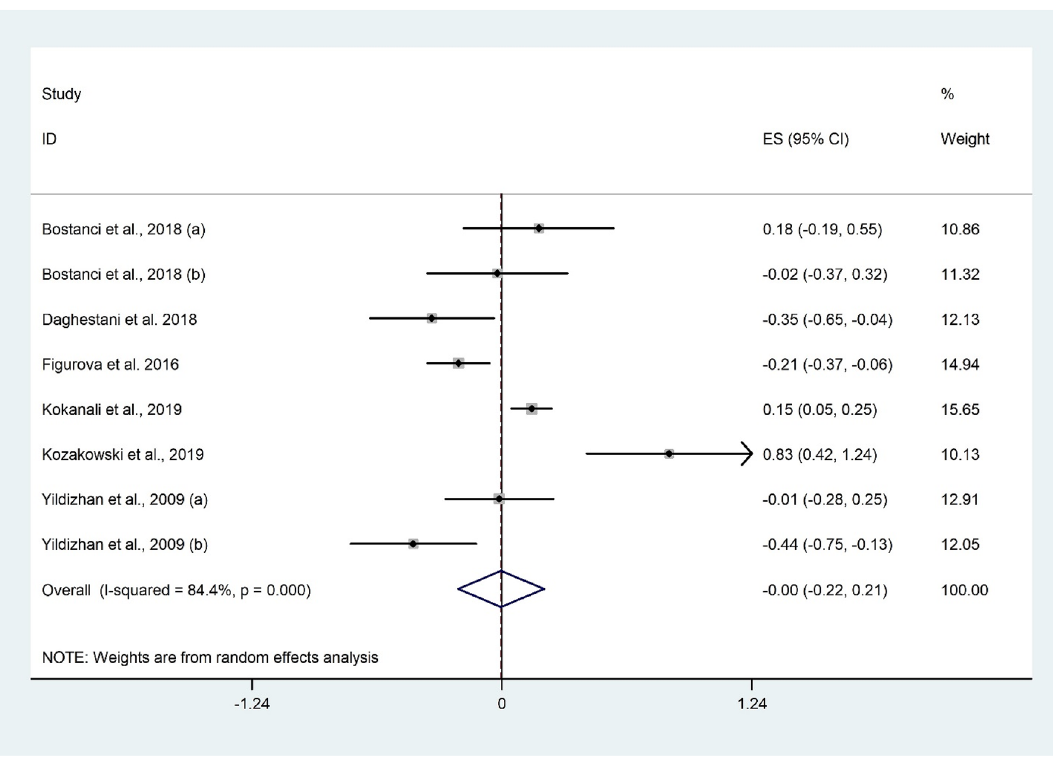
Figure 10. Forrest plot of the correlation between LH/FSH ratio and 25(OH)D